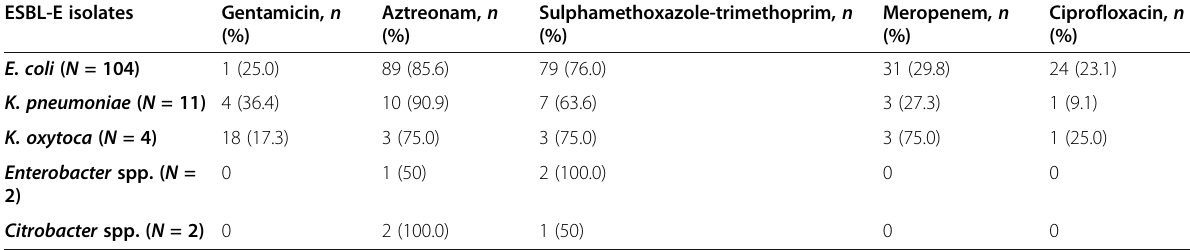
Table 5 Antimicrobial resistance patterns among ESBL-E isolates ESBL-E